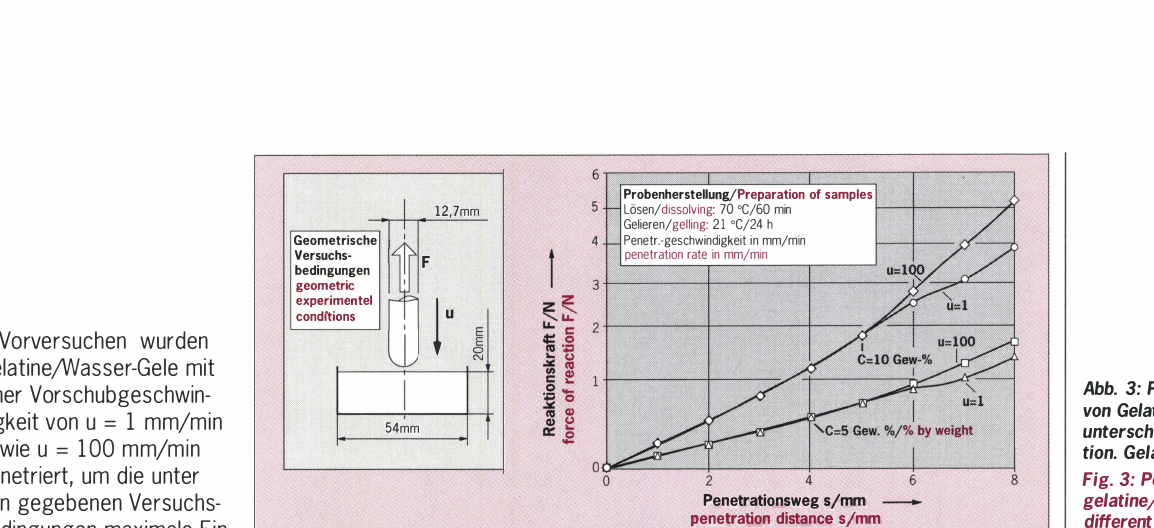
Fig. 3: Penetration curves for gelatine/water gels of different